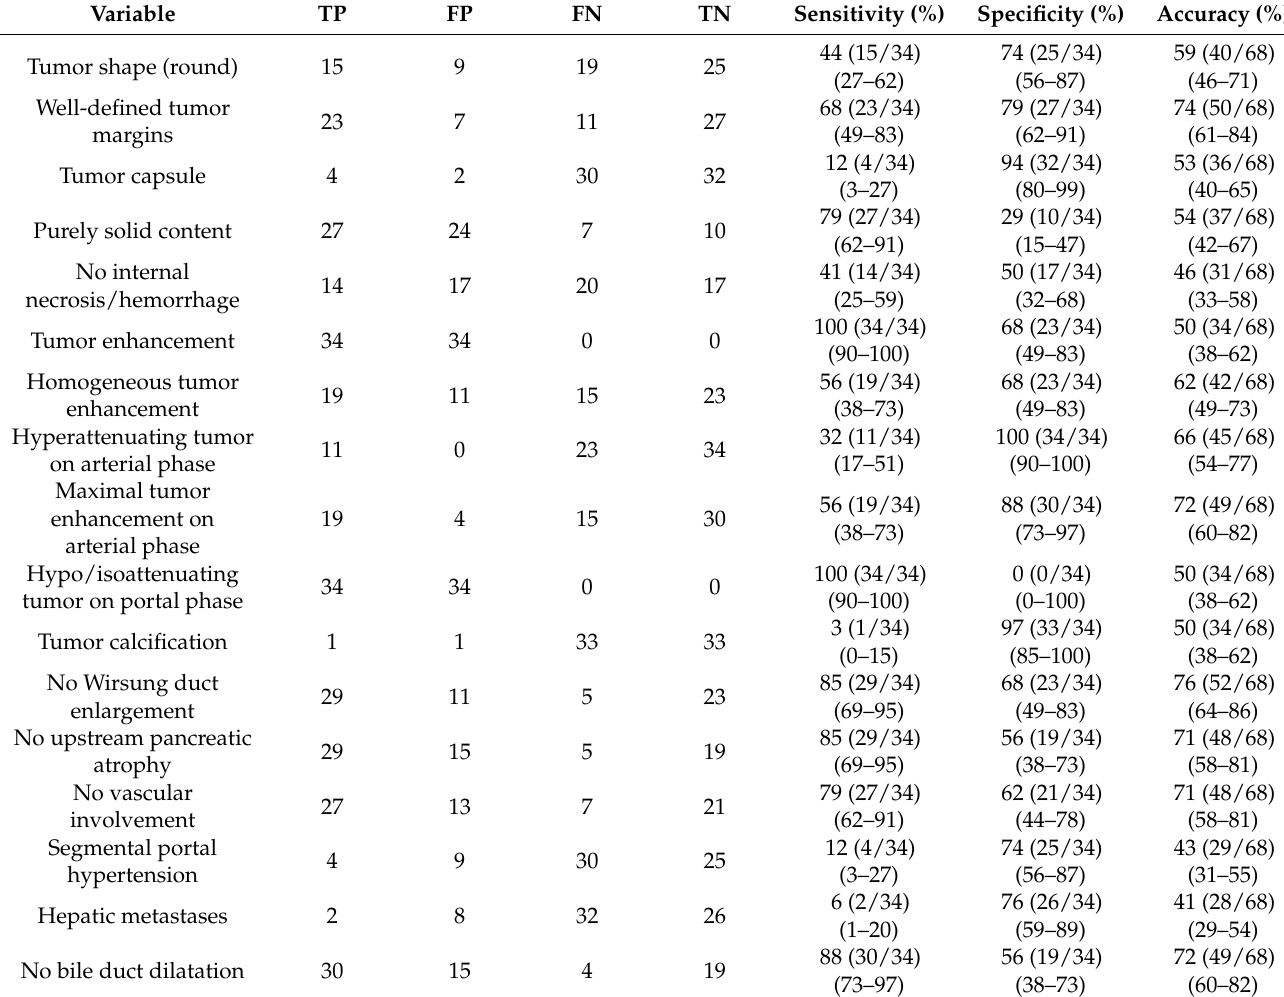
Table 2. Sensitivity, specificity and accuracy of categorical variables for the diagnosis of pancreatic parenchyma metastasis in 68